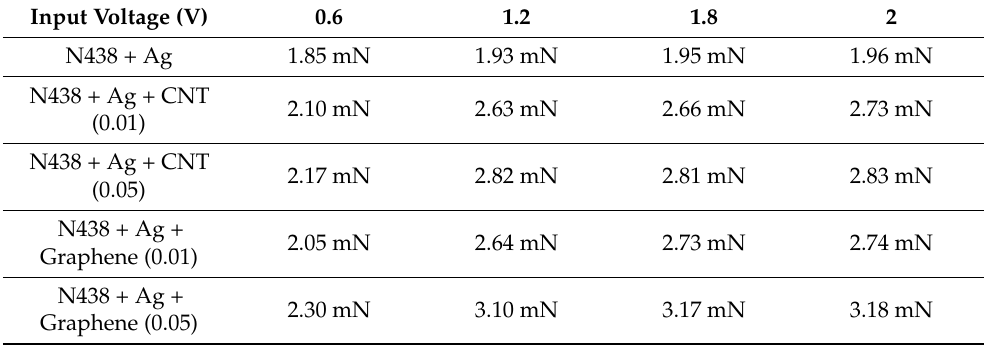
Table 6. Tip force of the IPMC membranes at different input